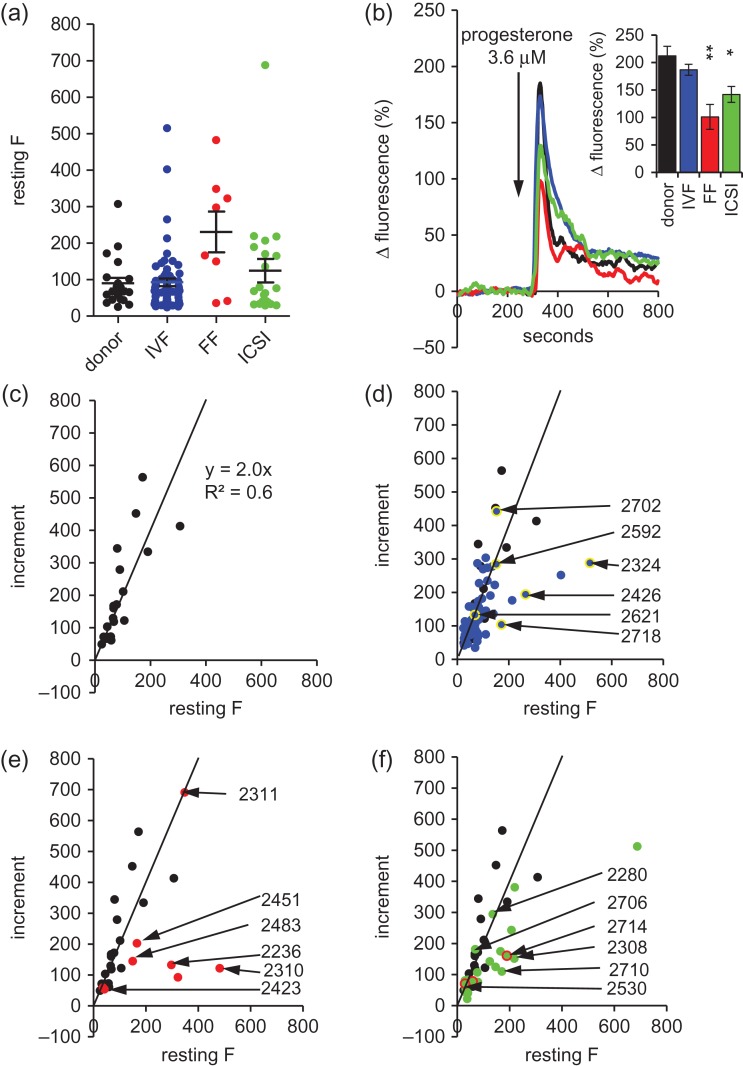
Resting fluorescence and population responses to P4. (a) Mean resting fluorescence for donor (black; n = 21 samples), IVF(+ve) (blue; n = 62 samples), IVF-FF (red; n = 8 samples) and ICSI (green; n = 21 samples) groups. Plots show individual values and mean ± SEM. (b) [Ca2+]i responses to P4 in donors (black), IVF(+ve) (blue), IVF-FF (red) and ICSI (green) groups. Arrow shows time of progesterone addition. Plots were obtained by normalizing data for each cell to pre-stimulus level, calculating the population response (mean of all cells imaged − ΔFmean) for each sample and then averaging these for the donors (n = 21 experiments) and for each of the three patient groups: IVF(+ve) (n = 62 experiments), IVF-FF (n = 8 experiments) and ICSI (n = 21 experiments). Inset shows mean (± SEM) normalized transient amplitude for each data set. Asterisks indicate P < 0.05 (*) and P < 0.01 (**) with respect to donor samples. (c) Relationship between mean resting fluorescence and mean fluorescence increment for 21 donor samples. Line shows fitted regression (y = 2.0x; R2 = 0.6). (d–f) Relationship between mean resting fluorescence and mean fluorescence increment for IVF(+ve) ((d) blue, n = 62 samples); IVF-FF ((e) red; n = 8 samples) and ICSI ((f) green, n = 21 samples), respectively. Numbered points (highlighted yellow in panel (d) for clarity) show patients for whom single cell analysis is shown in Fig. 2 and Supplementary Information Figs S3–S5. Points highlighted in red in panel (f) (ICSI) are patients who had previously failed to fertilize any oocytes at IVF. In each of panels (d–f) black points and fitted regression show data from donor samples for comparison.